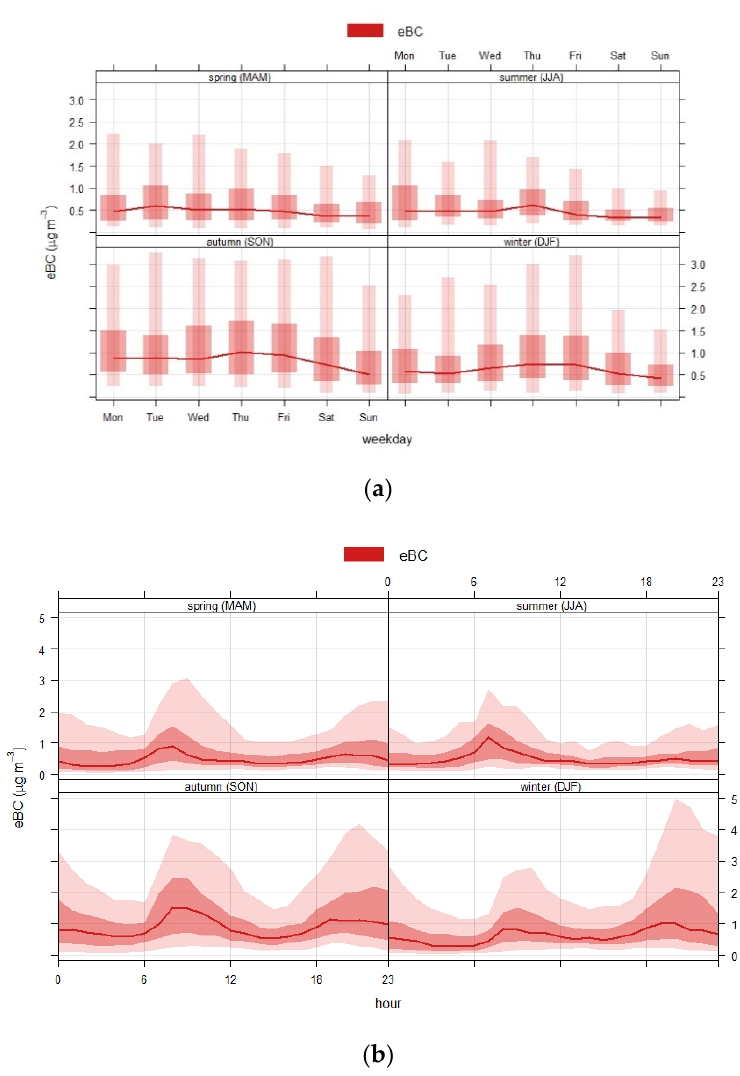
Figure 2. ( a ) Day of the week variation of median equivalent black carbon (eBC) concentrations. ( b ) Hour of day variation of median eBC concentrations. The shading shows the extent to the 25/75th and 5/95th quantiles.